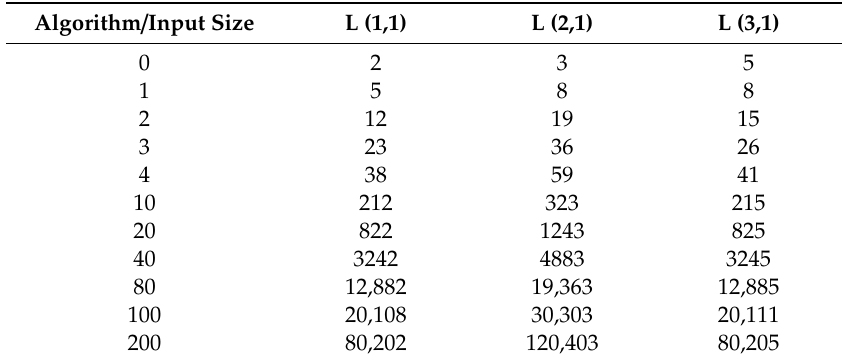
Table 3. Comparison of running times (in milliseconds) for each of the coloring algorithms for di ff erent input sizes (number of subscribers).